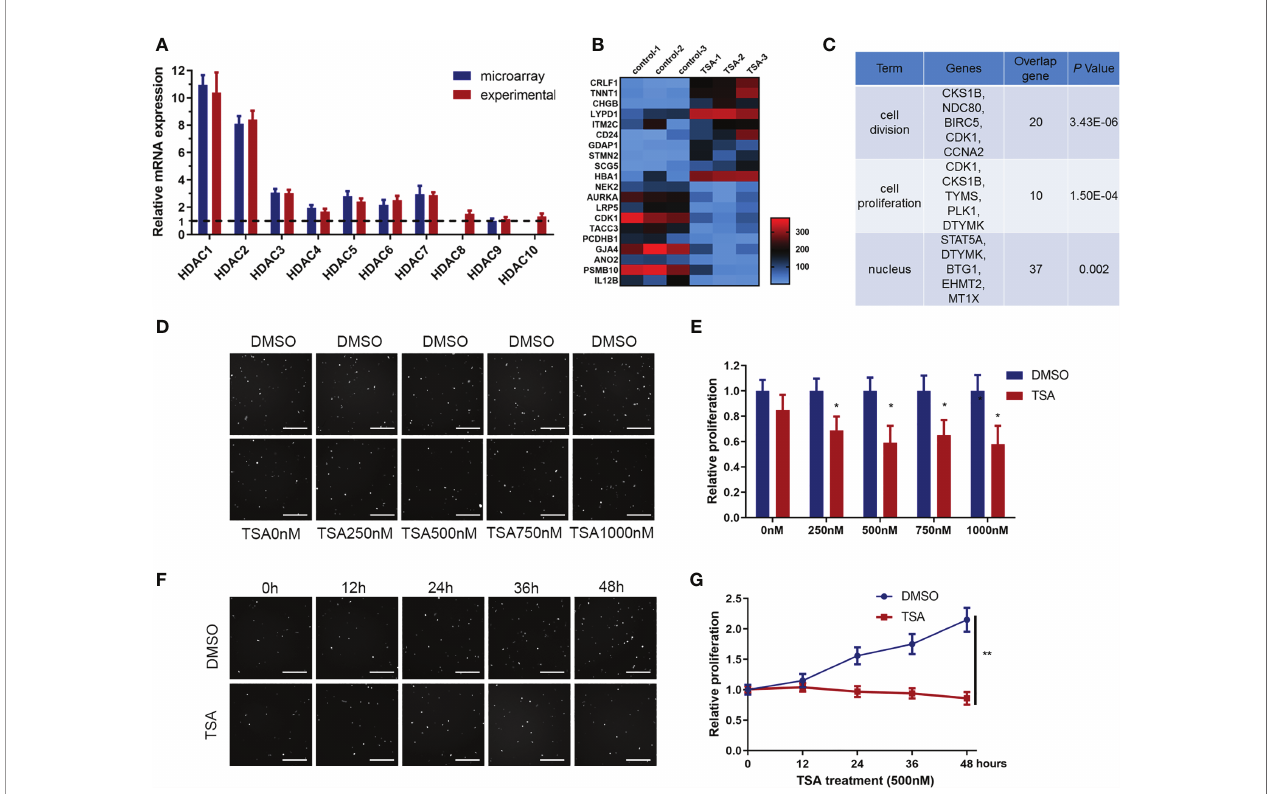
FIGURE 1 | Trichostatin A (TSA) reduced human umbilical vein endothelial cell (HUVEC) proliferation. (A) Differential expression of HDAC genes from the GEO database data (#GSE5856) was tested by qRT-PCR. The relative value of the lower HDAC9 level was set to 1.0 as reference. (B) mRNA expression pro fi ling of HUVECs with TSA treatment. HUVECs were grown and treated with TSA (500 nM for 24 h). Total RNAs isolated from experimental and control groups were subjected to microarray analysis. Heatmap was employed to visualize the top 20 genes. Shades of red represent increased gene expression, whereas shades of blue represent decreased expression. (C) Gene ontology enrichment performed by DAVID for gene expression pro fi ling. (D) HUVECs were treated with TSA or DMSO at different concentrations for 24 (h) Cell proliferation of HUVECs was analyzed by Cellomics ArrayScan VTI assay. Scale bar 400 m m. (E) Quanti fi cation of the data from (D) . (F) HUVECs were treated with 500 nM TSA or DMSO for different durations of time. Cell proliferation of HUVECs was measured with Cellomics ArrayScan VTI assay. Scale bar 400 m m. (G) Quanti fi cation of the data from (F) . The bars represent means ± SD from three independent experiments. *P < 0.05, **P < 0.01 vs . the control